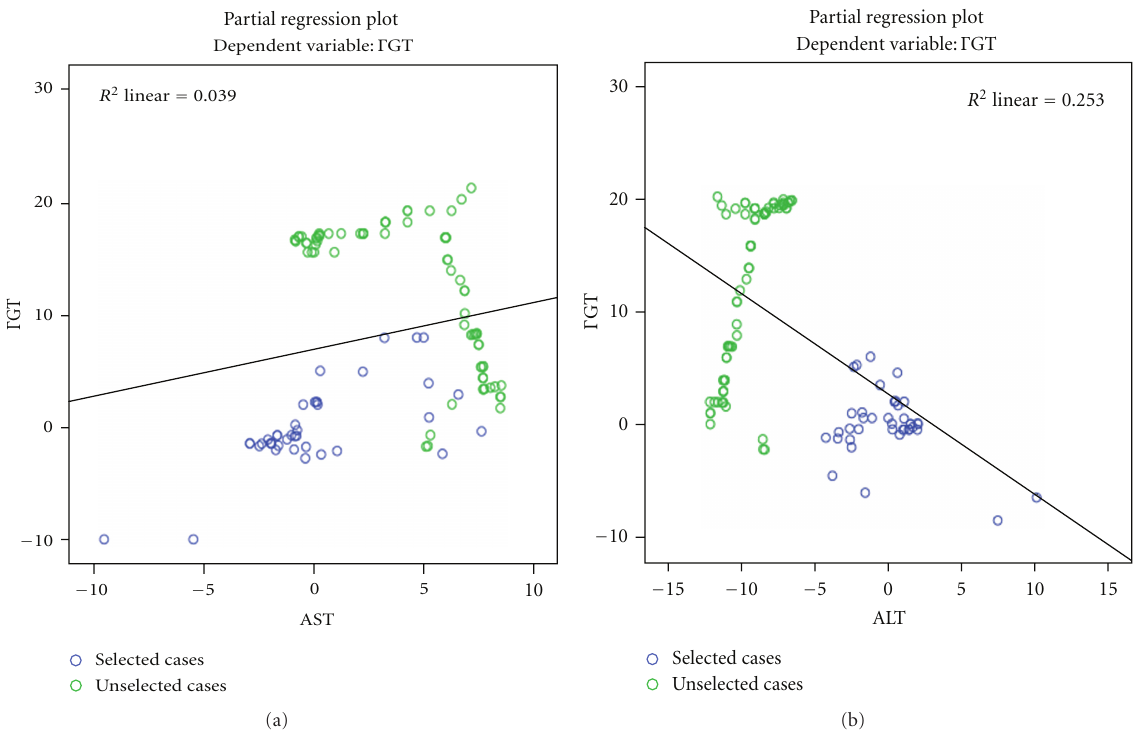
Figure 2: Multivariate relation between AST (a), ALT (b), and GGT at day 60 of initial phase of DOTS.